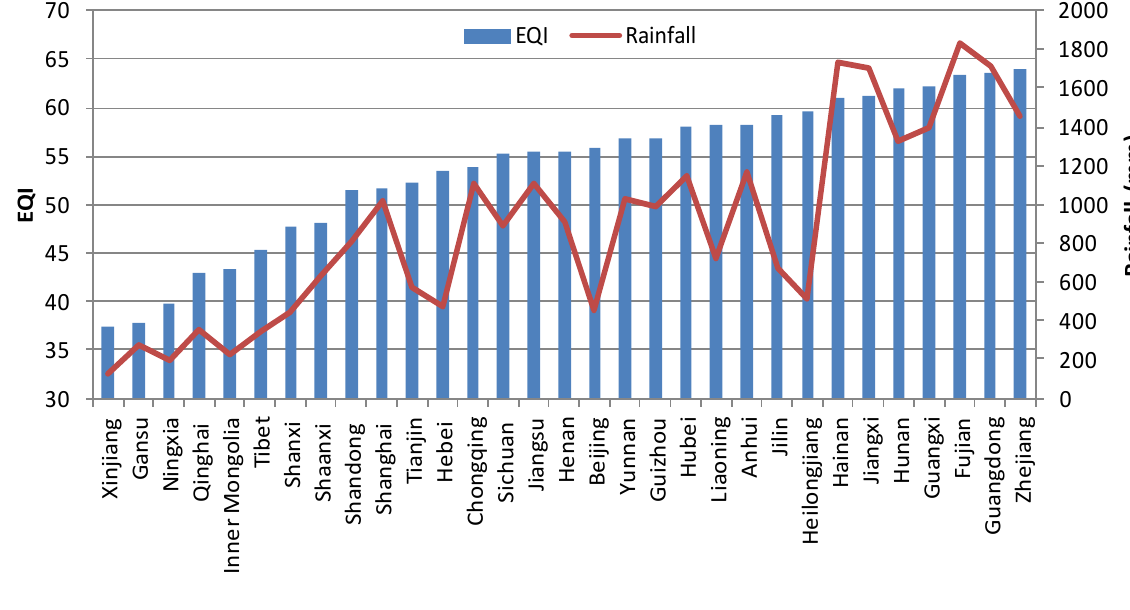
Figure 5. Comparison between rainfall and EQI over China at the provincial